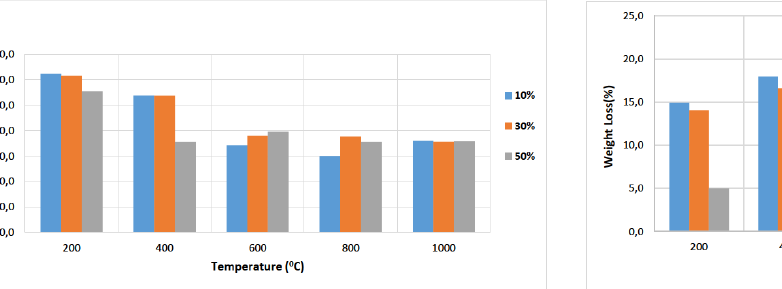
Figure 11: Weight loss of geopolymer foams with different content of basalt waste fibre at high